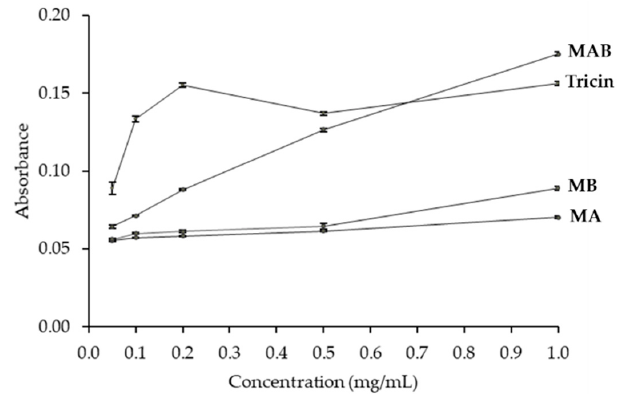
Figure 2. Reducing power activity of momilactones A, B, and tricin. Data expressed as means ± standard errors. MA, momilactone A; MB, momilactone B; MAB, the mixture of MA and MB at